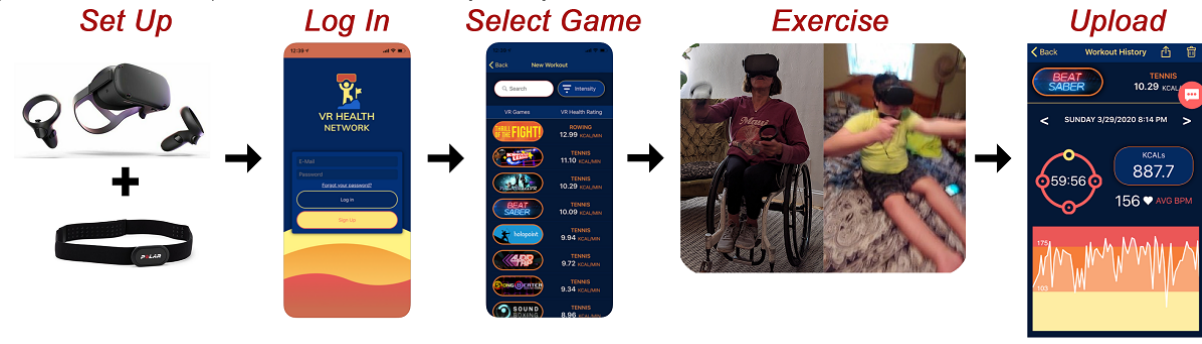
Figure 1. Exercise session procedures of the virtual reality (VR)